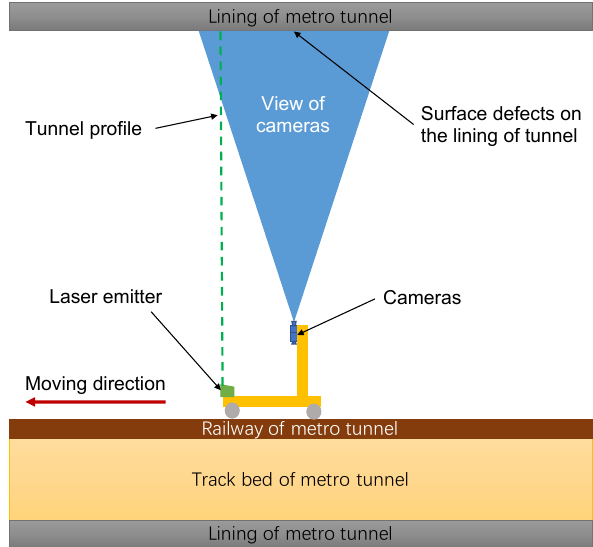
Figure 1. The design of obtaining surface defects and the cross-sectional profile, from the aspect of integrity.